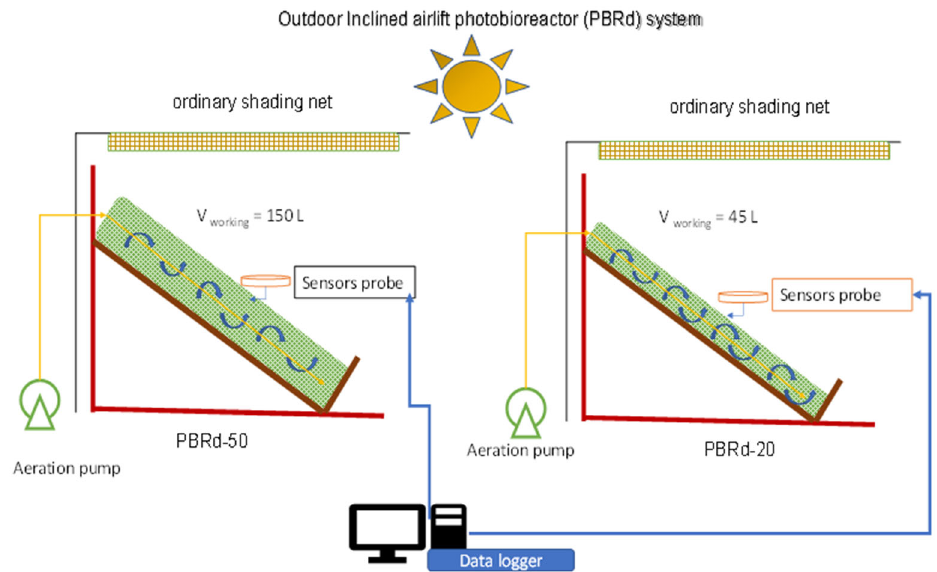
Figure 1. Schematic diagram of an outdoor inclined plastic column photobioreactor PBRd2021 series. The diameter of the plastic column (which contains A. platensis broth) varied between 12.74 (right) cm and 31.85 cm (left), giving the names PBRd ‐ 20 and PBRd ‐ 50.